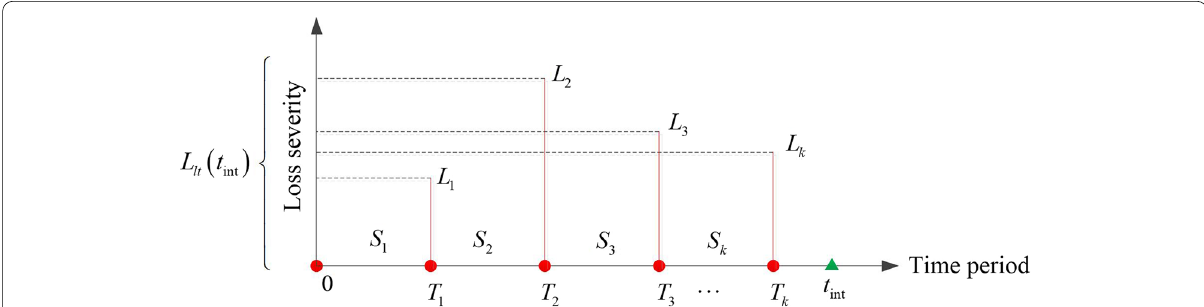
Fig. 1 The long-term loss considering discount and stochastic hazard